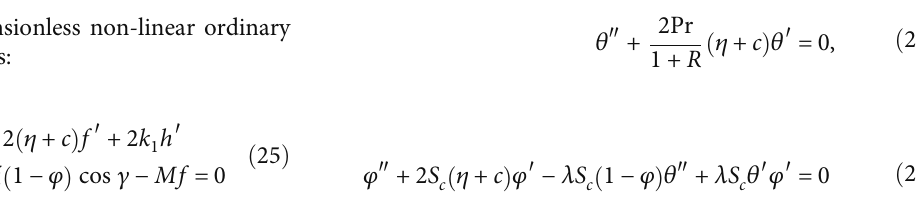
Figure 2: (a) Velocity, and (b) micro-rotation pro fi les with constant values of γ = 45 ° , R =0.5, Pr =0.71, Sc =0.22, L =0.5, Gr =10, Gc =10 for magnetic variation. K 1